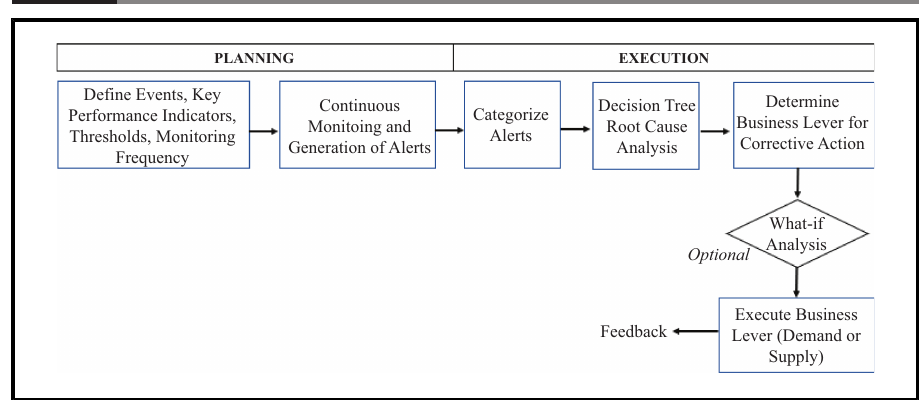
Figure 2 Events and alerts resolution PLANNING